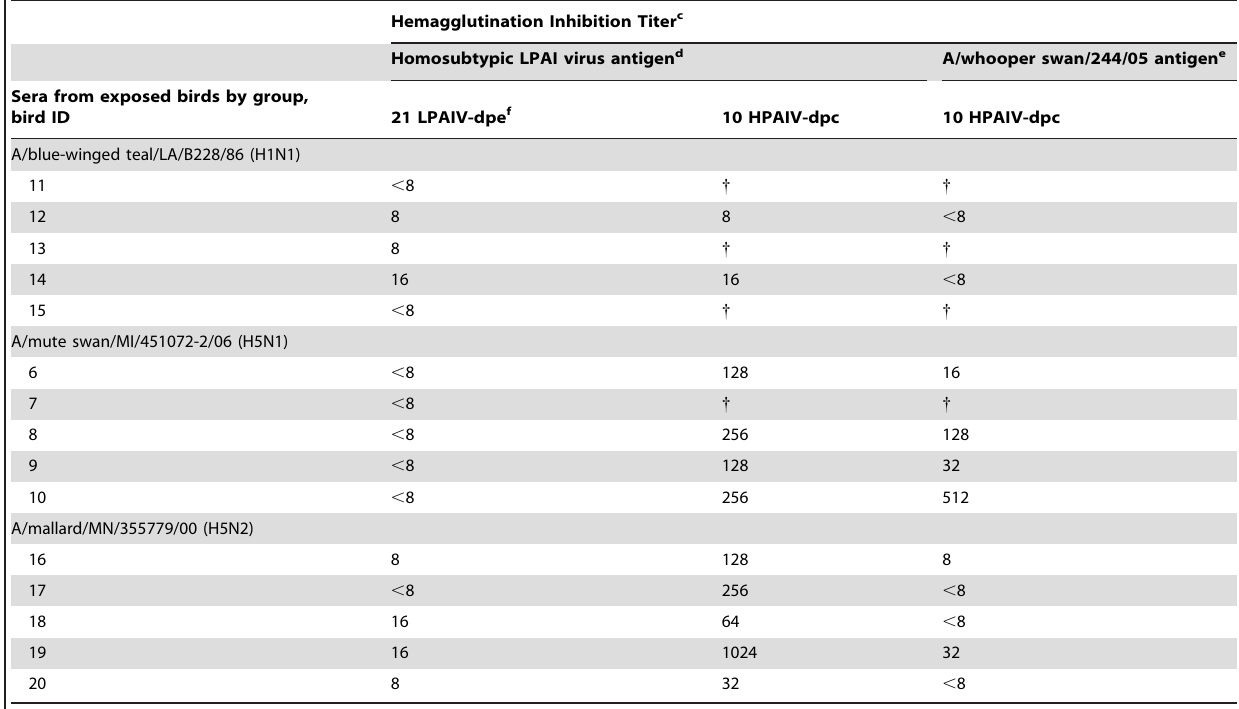
Table 2. Serological status, as determined by hemagglutination inhibition, of wood ducks ( Aix sponsa ) 21 days after experimental pre-exposure to low pathogenicity avian influenza (LPAI) viruses a , and 10 days after challenge with the highly pathogenic